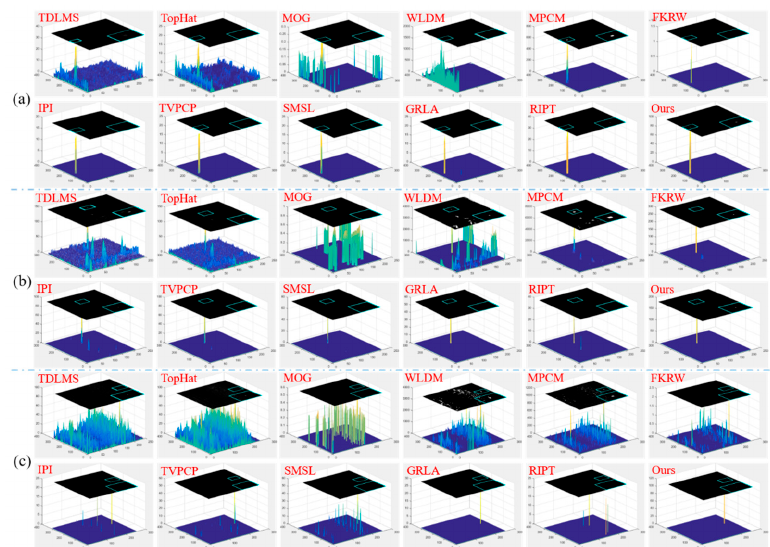
Figure 8. Detection results obtained by the proposed method over deep-space scenes compared with 11 comparative approaches. For better observation, the target images are integrated with their 3D stereogram. ( a ) Representative frame in Sequence 3. ( b ) Representative frame in Sequence 4. ( c ) Representative frame in Sequence 5.